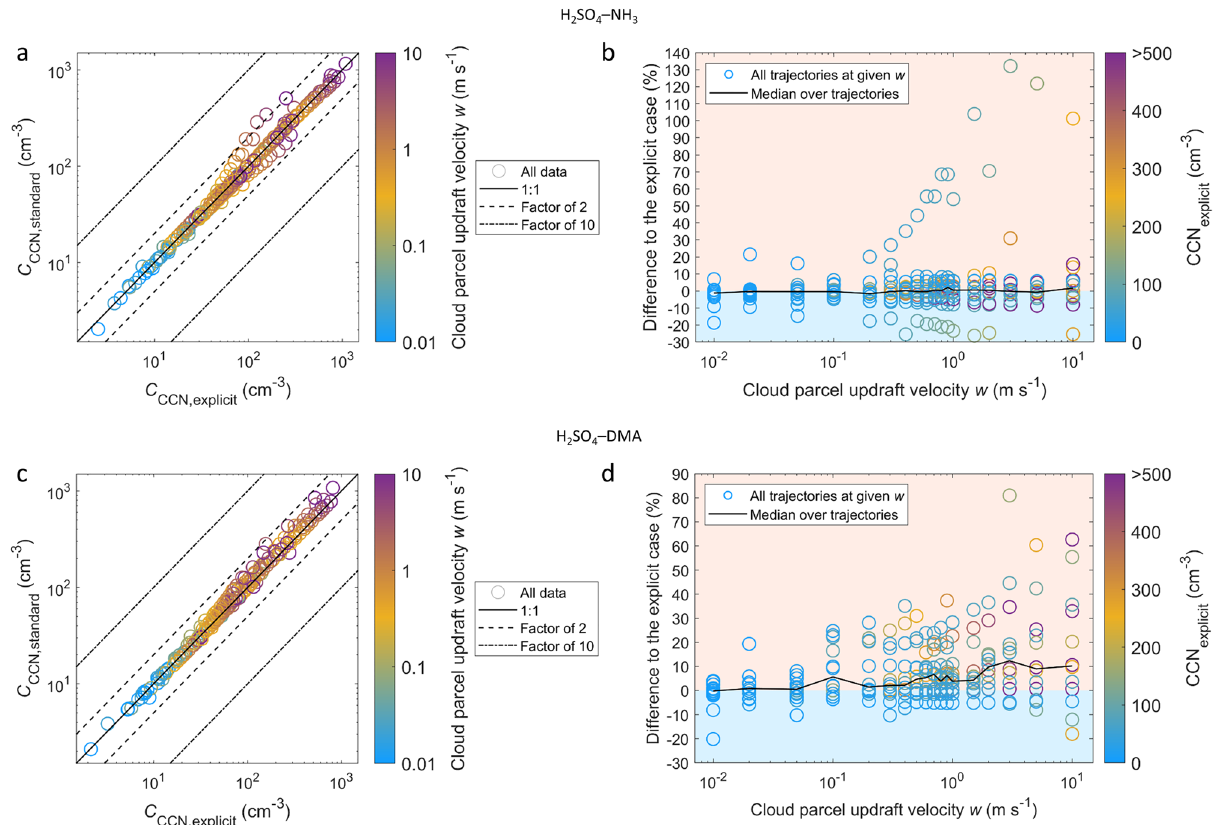
Figure 6. CCN number concentrations for the standard and explicit cases at the ends of the trajectories with initial particle formation from H 2 SO 4 –NH 3 ( a,b ), and H 2 SO 4 –DMA ( c,d ). ( a,c) show the absolute concentrations C CCN at different cloud parcel updraft velocities w , as indicated by the color scale. ( b,d) show the difference Δ C CCN = ( C CCN,standard − C CCN,explicit ) / C CCN,explicit between the standard and explicit cases as a function of w for all trajectories, and the median of Δ C CCN over the trajectories at given w . Regimes of under- and overprediction are depicted by light blue and light red shades,